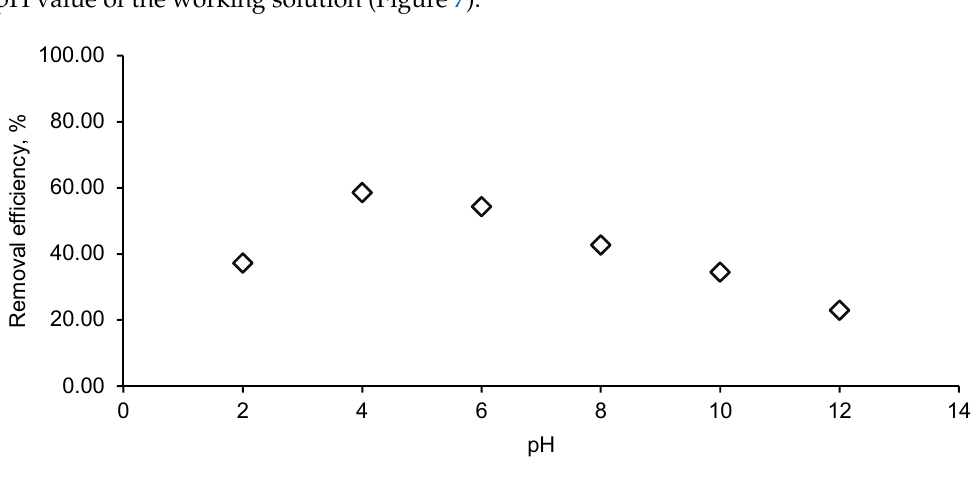
Figure 8. Biosorbent dose influence on CPX removal efficiency (CPX solution volume: 25 mL; CPX initial concentration: 50 mg/L; CPX initial solution pH: 4).